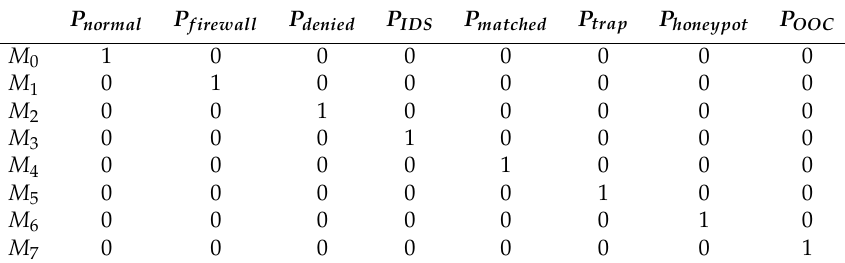
Table 4. Reachable markings’ set of Scenario